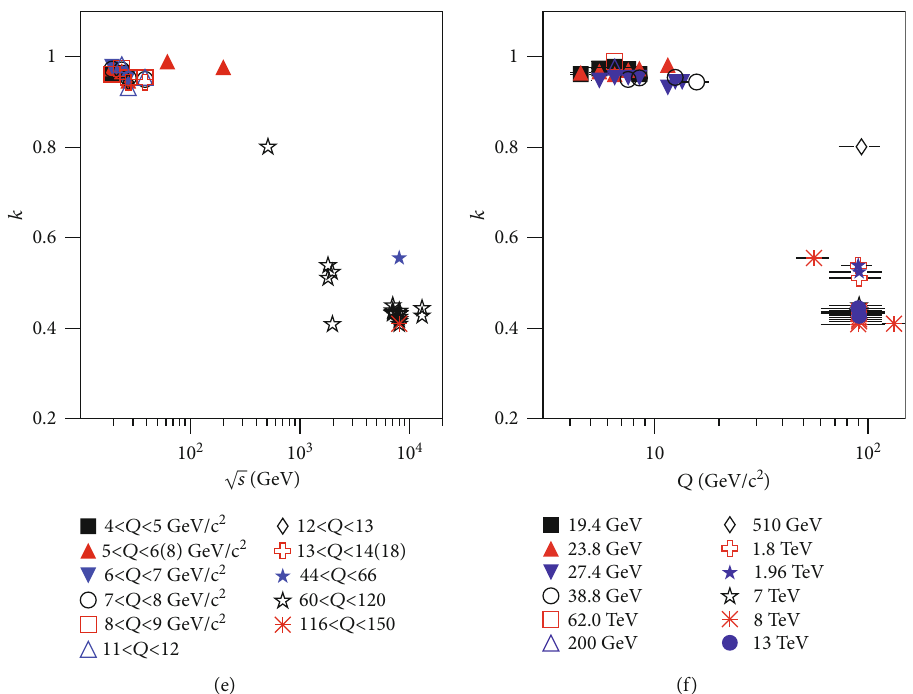
i h p i t t S (a, b), H (c, d), and